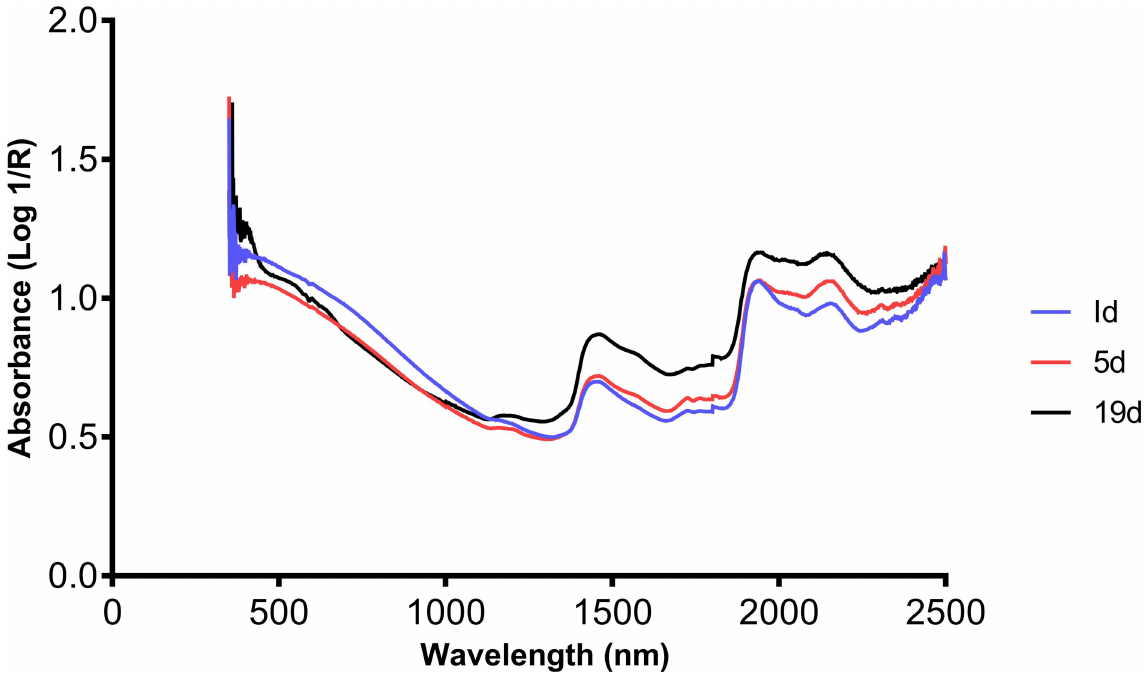
Fig 1. Example of typical raw spectra collected from heads and thoraces of w Mel infected female Ae . aegypti at 3 different age points.